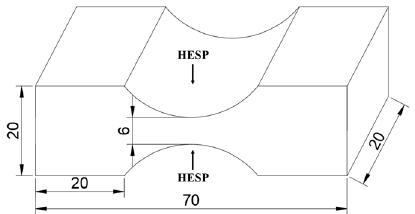
Figure 2. Dimensions of the tensile fatigue test sample (mm).